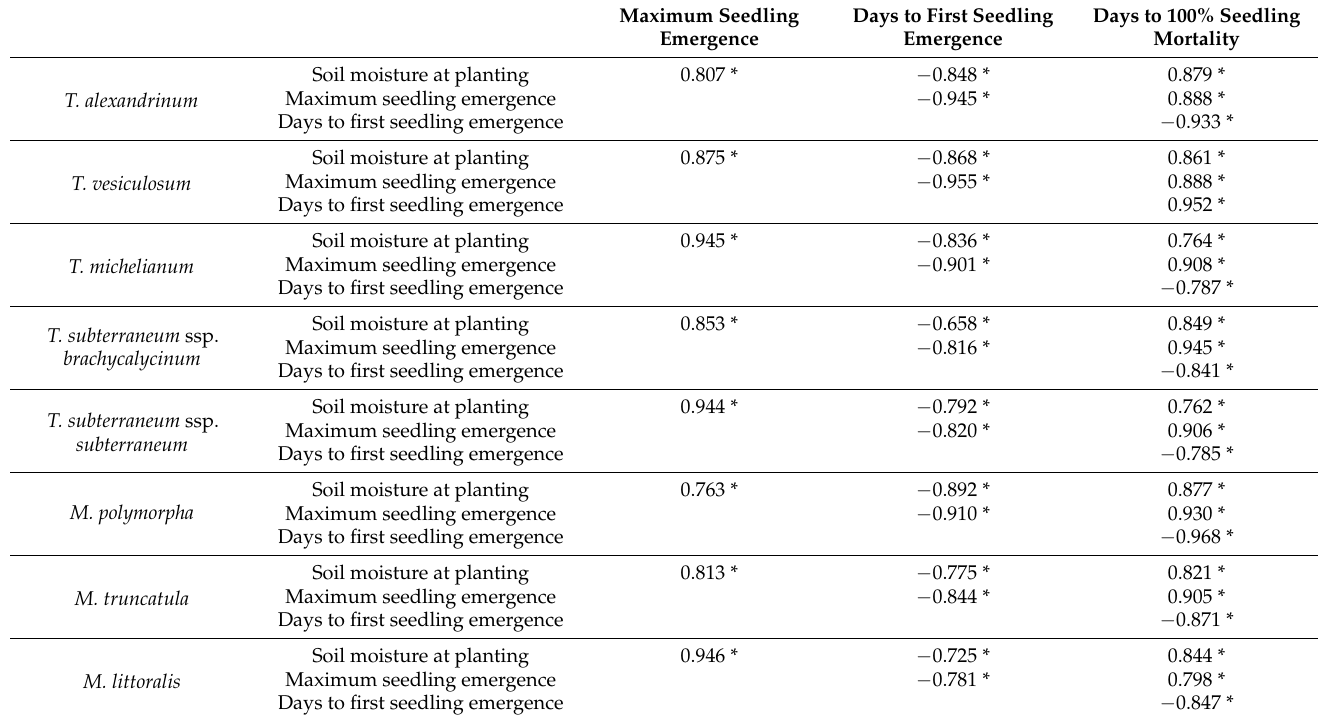
Table 3. Pearson’s correlation coefficients between the different vigor indices and soil moisture contents at planting of three annual Medicago and five annual Trifolium species (* p <